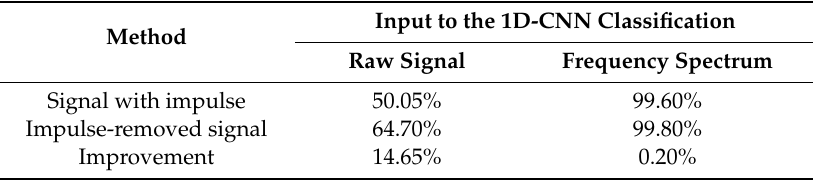
Table 3. Results of leakage